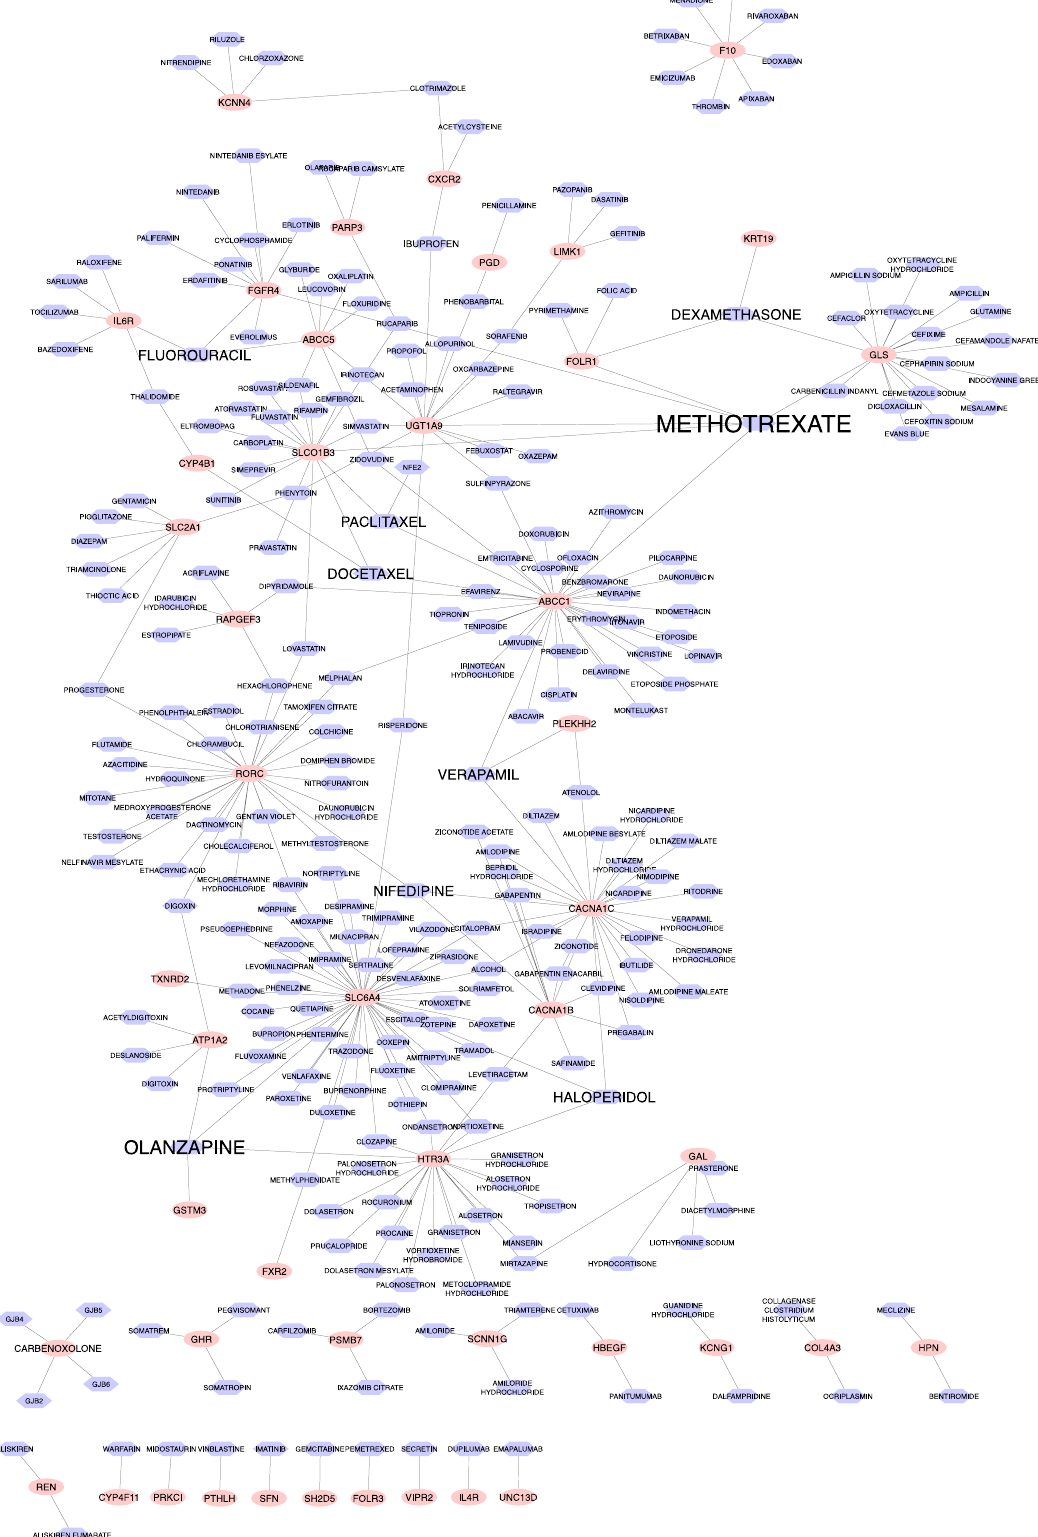
Figure 4. The drug–gene interaction network. Totally, 277 candidate drugs were identified as regulators of the purple and magenta modules of the NSCLC network. The red circle shapes and blue hexagon shapes represent genes and drugs, respectively (this figure was drawn in the Cytoscape 43 v.3.8.2